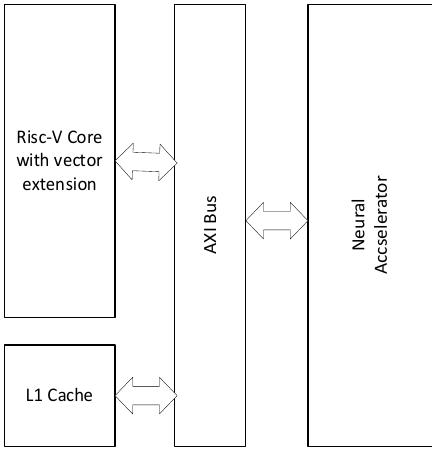
Fig. 3. Structure of the interaction of a neural accelerator and the RISC-V